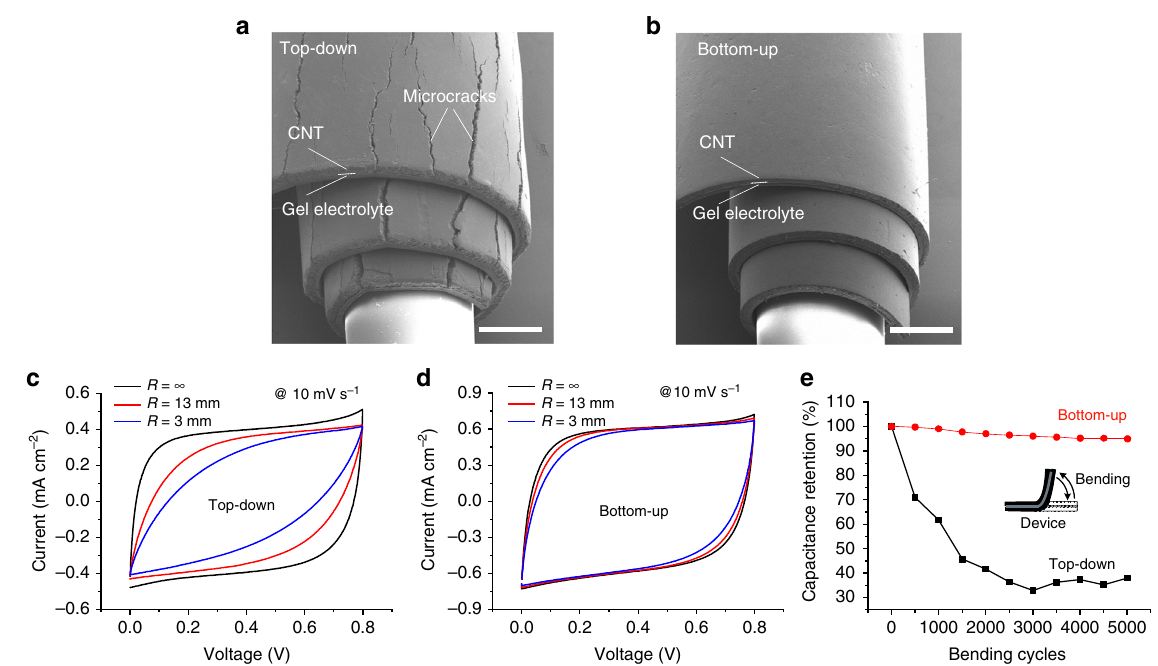
Fig. 3 Gel fi lling method dependent mechanical stability. a , b The gel in fi lling-dependent microcracks (or lack of microcracks) in ~150 μ m in thick MWCNT electrodes rolled-up over a glass tube with a radius of ~0.5 mm fabricated by the two methods. Electrochemical performance of c and d once rolled-up FSSC devices and e after repeated bending. In e the capacitance retention with the bending number is con fi rmed by GCD at a current density of 0.15 mA after every 500 bends at bending radius of curvature of 5.7 mm. Scale bar for a and b is 500 μ